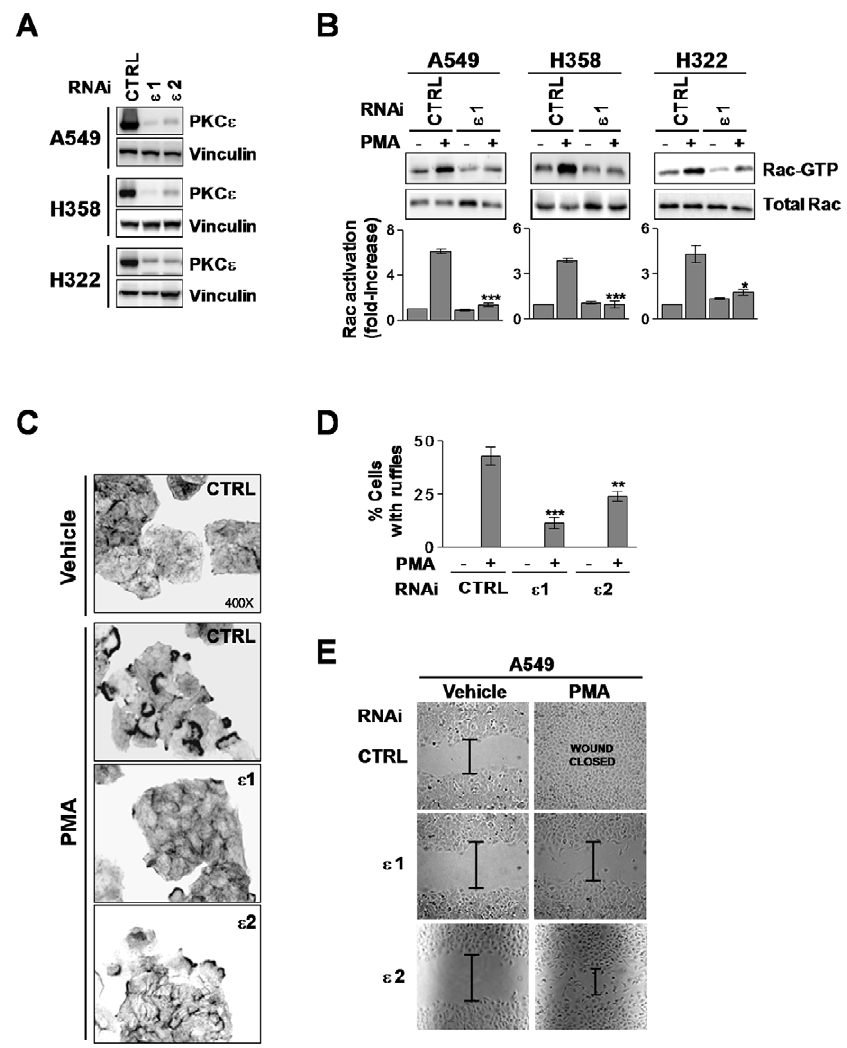
Figure 2. PKC e mediates Rac activation and Rac-mediated responses induced by PMA. A. NSCLC cells were transfected with either PKC e RNAi ( e 1 or e 2) or control ( CTRL ) RNAi and serum starved for 24 h. A representative Western blot for PKC e expression at the time of PMA treatment is shown (n=3). B. Cells subject to PKC e or control RNAi were stimulated with PMA (100 nM, 2 min) and Rac-GTP levels determined using a pull-down assay.A representative experiment is shown. The fold-induction in Rac-GTP levels normalized to total Rac at time=0, as determined by densitometry, is represented in the bottom graphs. Data are expressed as mean 6 S.D. (n=3). *, p , 0.05; ***, p , 0.001. C. A549 cells were treated with PMA (100 nM, 30 min), fixed, and stained with phalloidin-rhodamine. Representative micrographs are shown (n=3). D. Quantification of A549 cells bearing ruffles, expressed as mean 6 S.D. of 3 individual experiments. **, p , 0.01; ***, p , 0.001. E. Closure of wounds in response to PMA (100 nM, 30 min) was recorded at 9 h (A549 cells). Experiments were carried out in triplicate plates. Results are expressed as percentage of the closure induced by PMA, and expressed as mean 6 S.E.M. (n=3). ***, p , 0.001.